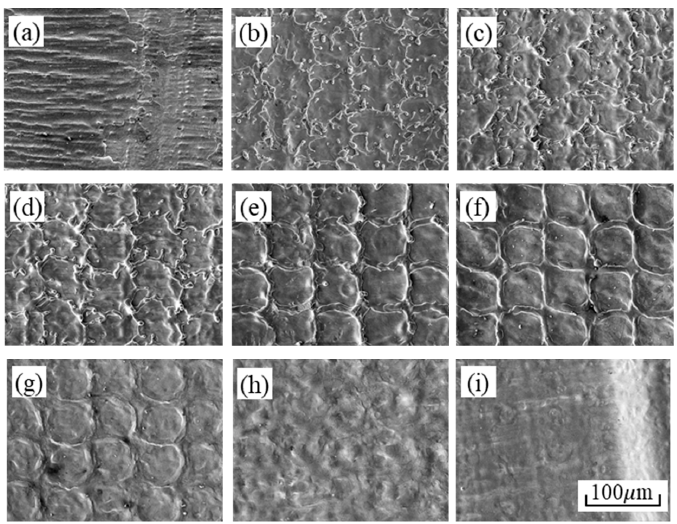
Figure 7. Morphology of the weld surface before and after laser cleaning according to defocus dis- tance; ( a ) Un-cleaned, ( b ) f d = 0 mm, ( c ) f d = +1 mm, ( d ) f d = +2 mm, ( e ) f d = +3 mm, ( f ) f d = +4 mm, ( g ) f d = +5 mm, ( h ) f d = +6 mm, ( i ) f d = +7 mm.